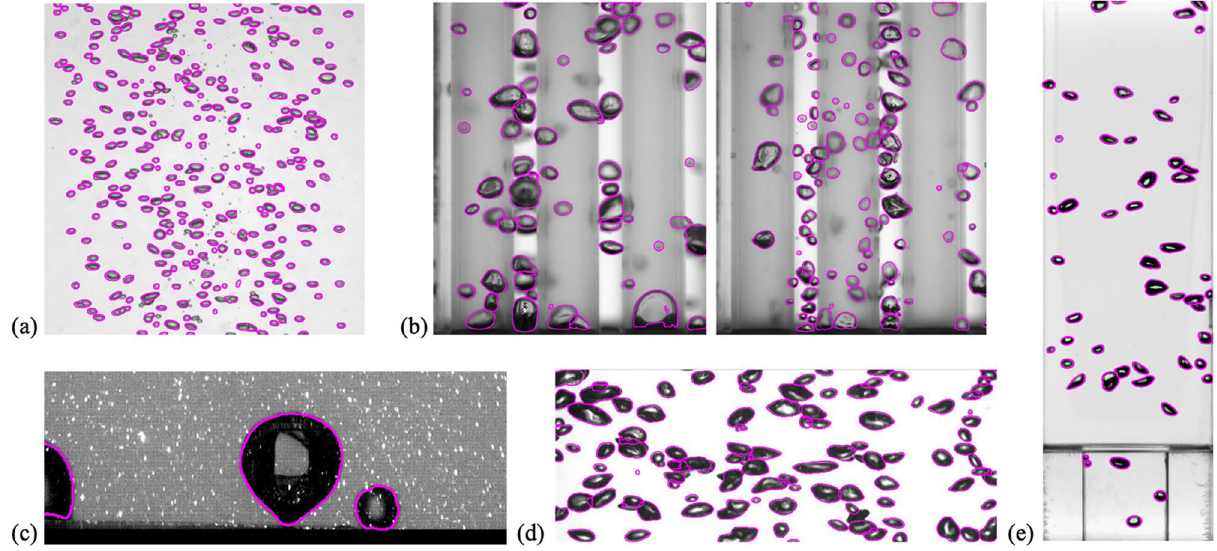
Figure 6. Bubble detection and mask extraction results for various gas–liquid two-phase flow experiments: ( a ) bubble plume ( J G = 0.033 × 10 –3 m/s, d e = 1.8 mm) (unpublished data); ( b ) bubbly flow in a rod-bundle of nuclear power plant ( J G = 0.008 m/s, J L = 0, 0.68 m/s, d e = 2.8 and 2.0 mm) (unpublished data); ( c ) pool boiling bubble ( T